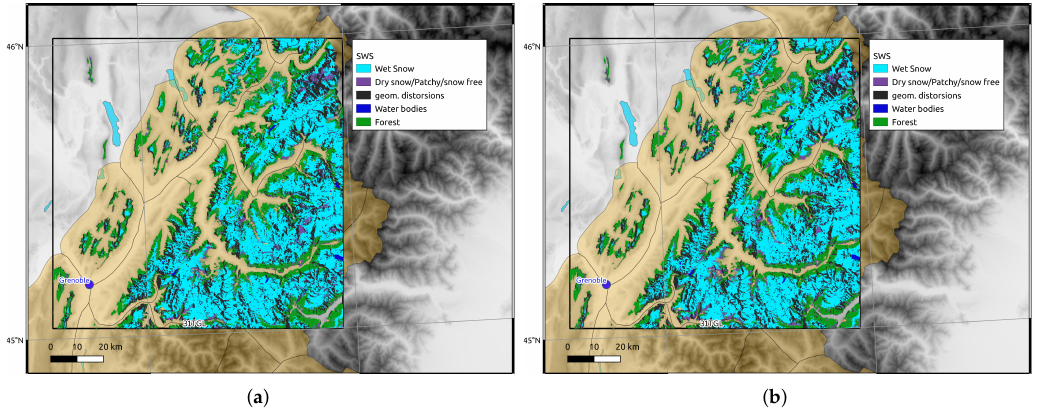
Figure 3. Maps of Sentinel-1 SWS wet snow products derived from the ascending orbit A161 as of ( a ) 16 April 2018 and ( b ) 22 April